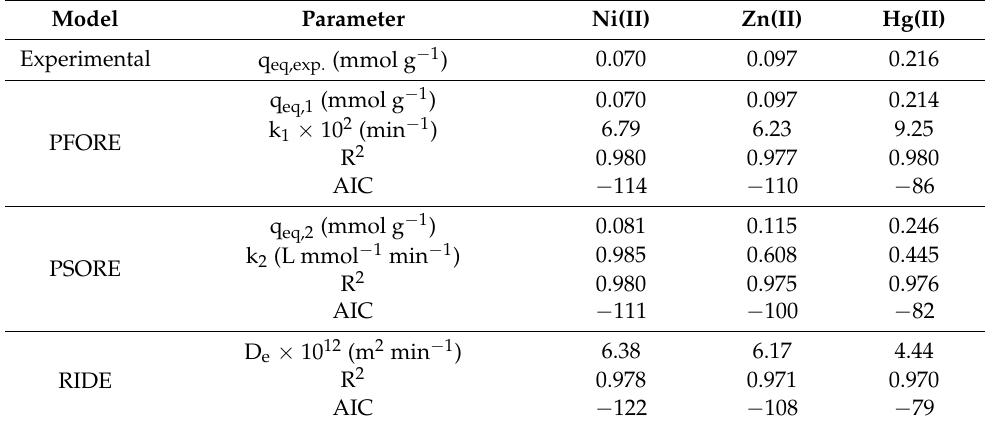
Table 2. Ni(II), Zn(II) and Hg(II) uptake kinetics using G@MChs for multi-component solutions— parameters of the models.